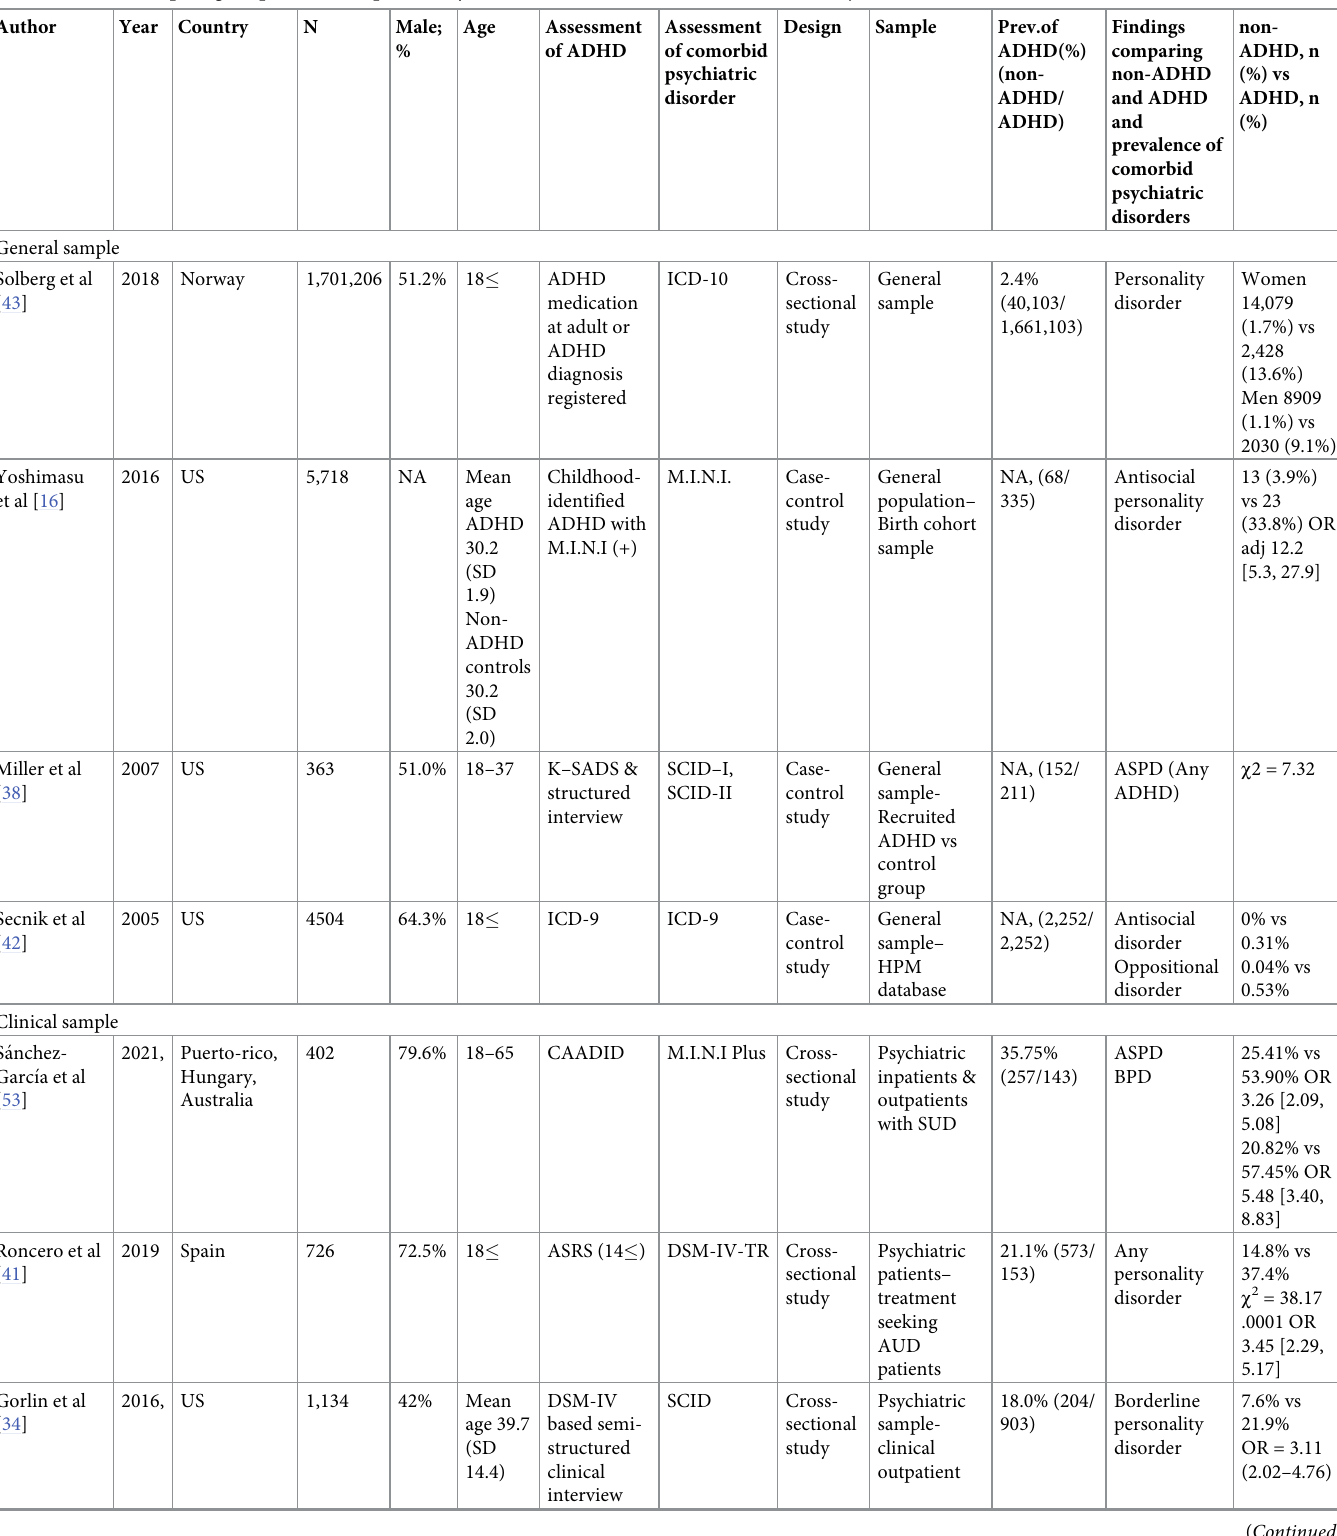
Table 4. Studies comparing the prevalence of personality disorder between non-ADHD and ADHD